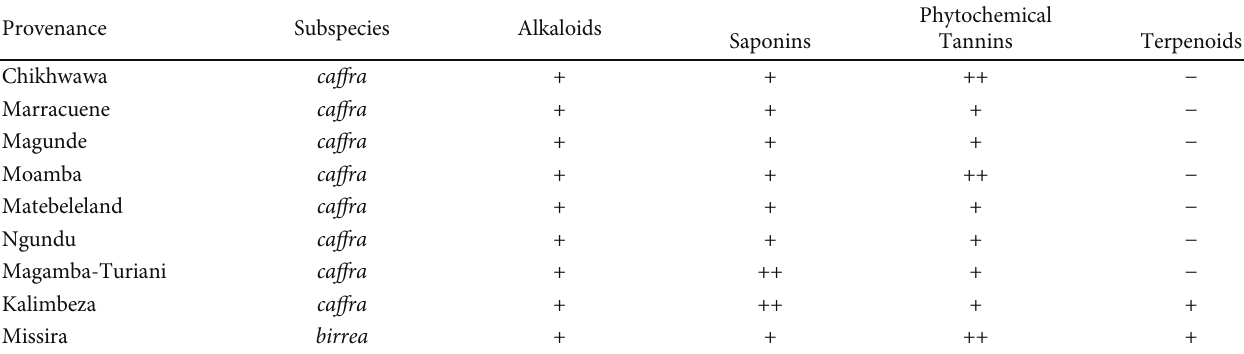
Table 5: Phytochemical composition of S. birrea (subspecies ca ff ra and birrea ) seed kernel between